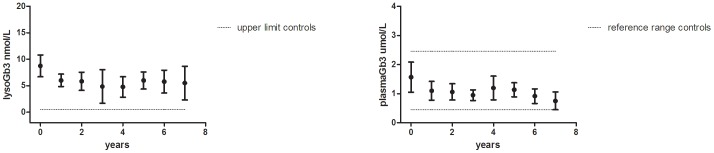
Plasma lysoGb3 and Gb3 in Fabry females.Plasma lysoGb3 in 27 (A) and Gb3 (B) in 28 Fabry females, treated for at least one year, depicting mean and 95% CI.